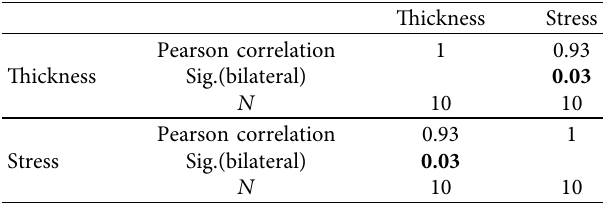
Table 6: The results of the Pearson test of correlation between the stress and the steel piece